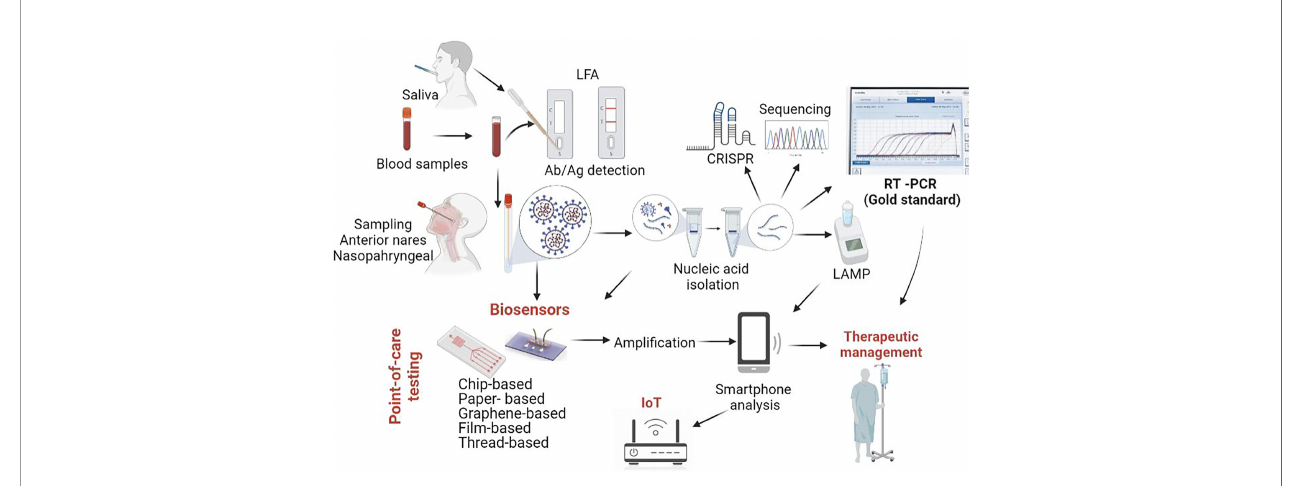
FIGURE 1 | SARS-CoV-2 diagnostic tools. While Real Time PCR from nasopharyngeal swabs represents the gold standard from COVID-19 diagnostic, other approaches are currently being employed or developed. Among these, research is focused on various types of biosensors (chip based, paper based, graphene- based biosensors), some of them coupled with smartphone analysis. Original fi gure, created using